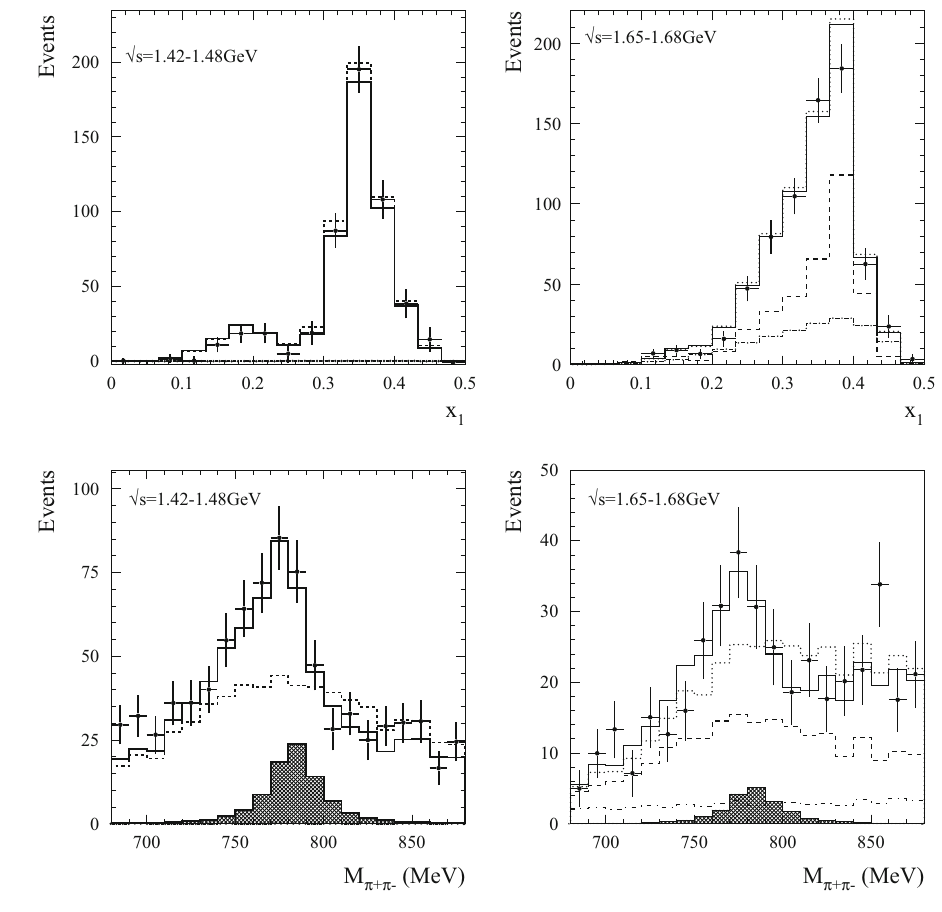
e √ s=1.42-1.48GeV v E